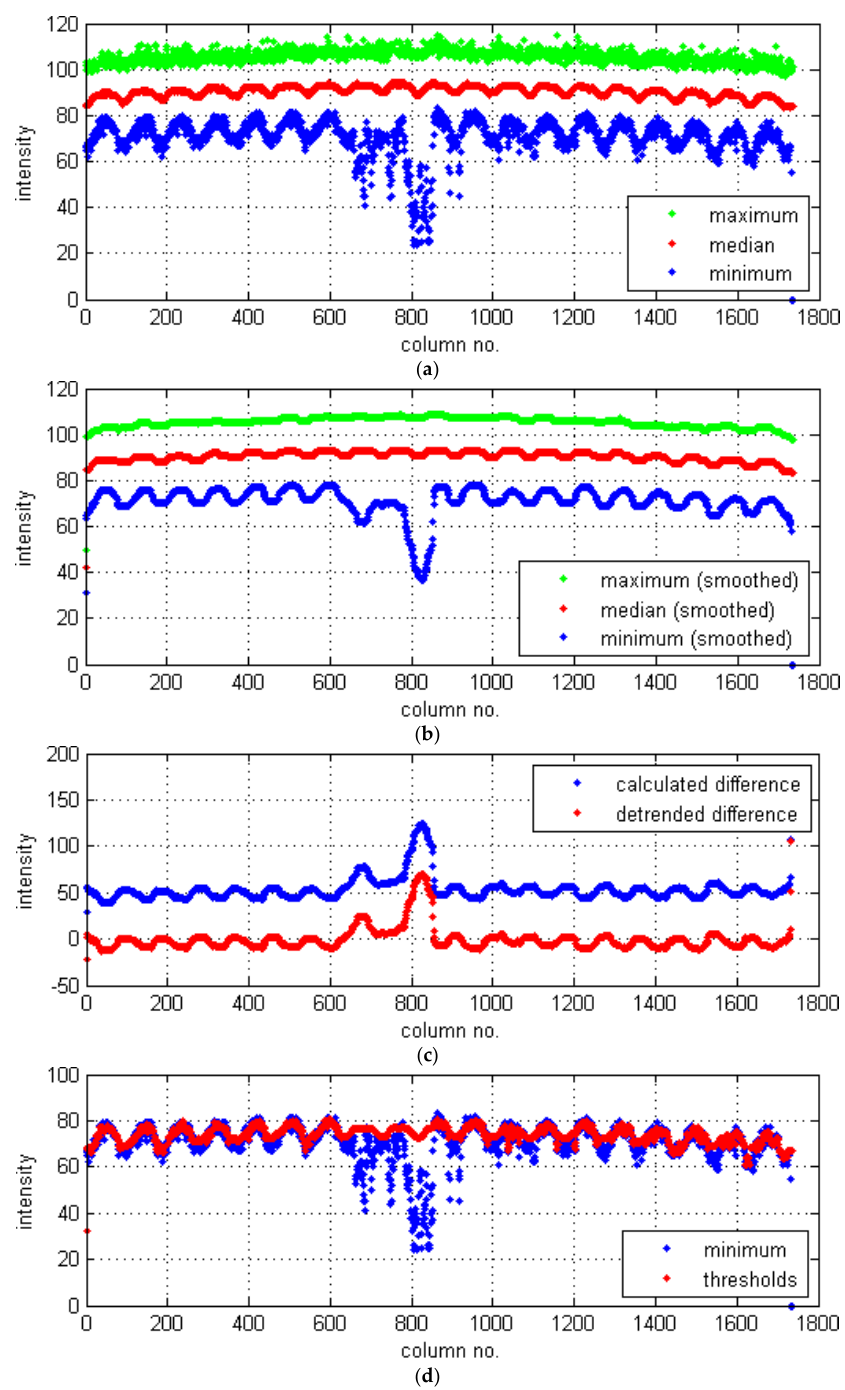
Figure 18. Column-based calculations of the texture characteristics of the CT slice: ( a ) statistical values; ( b ) statistical values after smoothing; ( c ) differences; ( d ) extracted threshold values.